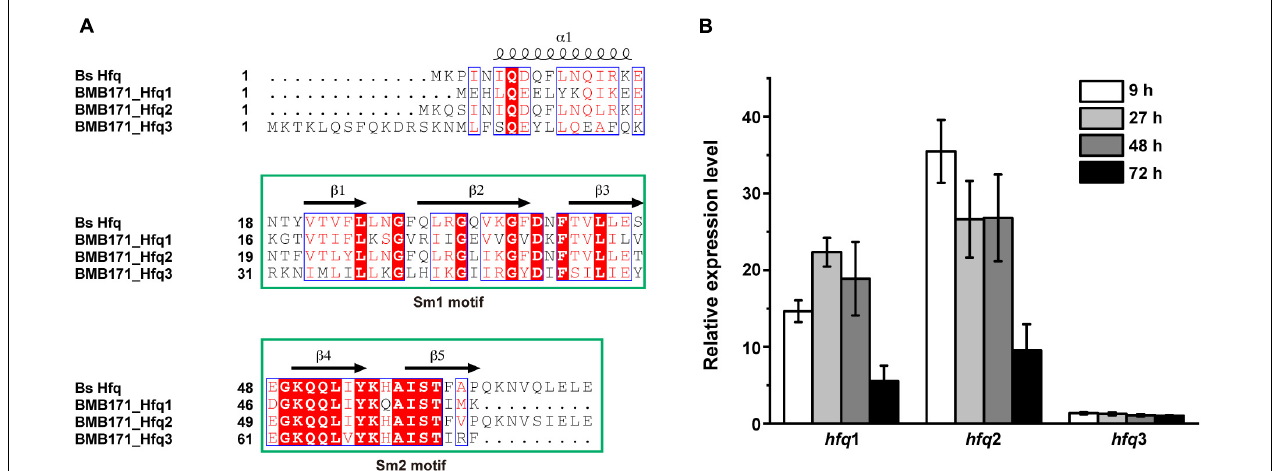
FIGURE 1 | Sequence alignment and gene expression of three Hfq proteins in BMB171. (A) Secondary structure analysis of the three Hfq proteins in BMB171. Their amino acid sequences all contain two motifs, with Sm1 containing the conserved β 1- β 3 strands and Sm2 containing the β 4- β 5 strands. (B) Gene expression levels of the three hfq genes in BMB171 at different growth phases. Samples were taken at 9 h (logarithmic phase), 27 h (early stationary phase), 48 h (late stationary phase or early sporulation phase), and 72 h (final sporulation